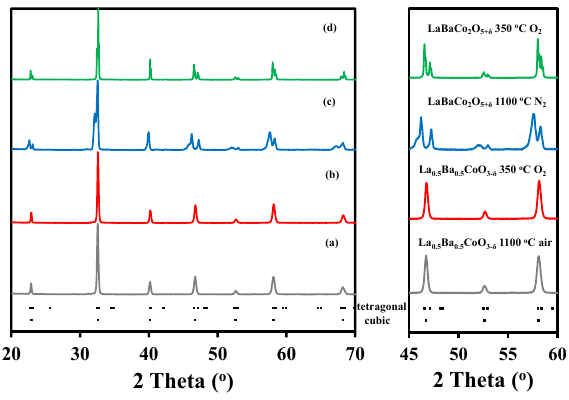
Figure 1. Full range and selected range X ‐ ray diffraction patterns recorded at room temperature of: ( a ) La 0.5 Ba 0.5 CoO 3 ‐δ after treatment at 1100 °C for 12 h in air; ( b ) La 0.5 Ba 0.5 CoO 3 ‐δ after treatment at 350 °C for 24 h in O 2 ; ( c ) LaBaCo 2 O 5+ δ after treatment at 1100 °C for 12 h in N 2 ; and ( d ) LaBaCo 2 O 5+ δ after treatment at 350 °C for 24 h in O 2 . The Bragg reflections for both tetragonal and cubic cells are included at the bottom.